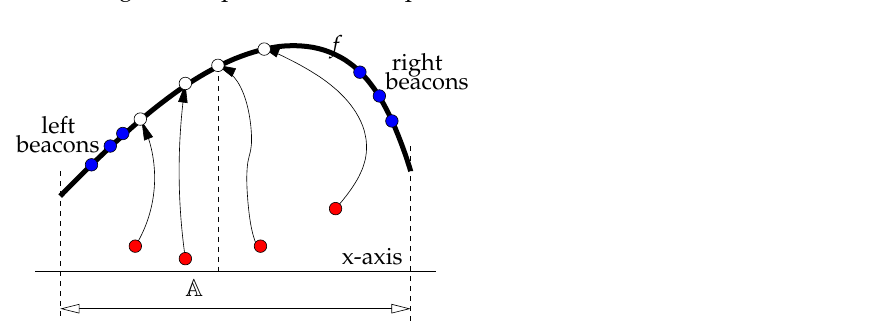
Figure 5. An illustration of Beacon-Directed Curve Positioning (BDCP). Red (resp., white) circles denote the initial (resp., final) positions of n = 4 robots. Blue circles denote the